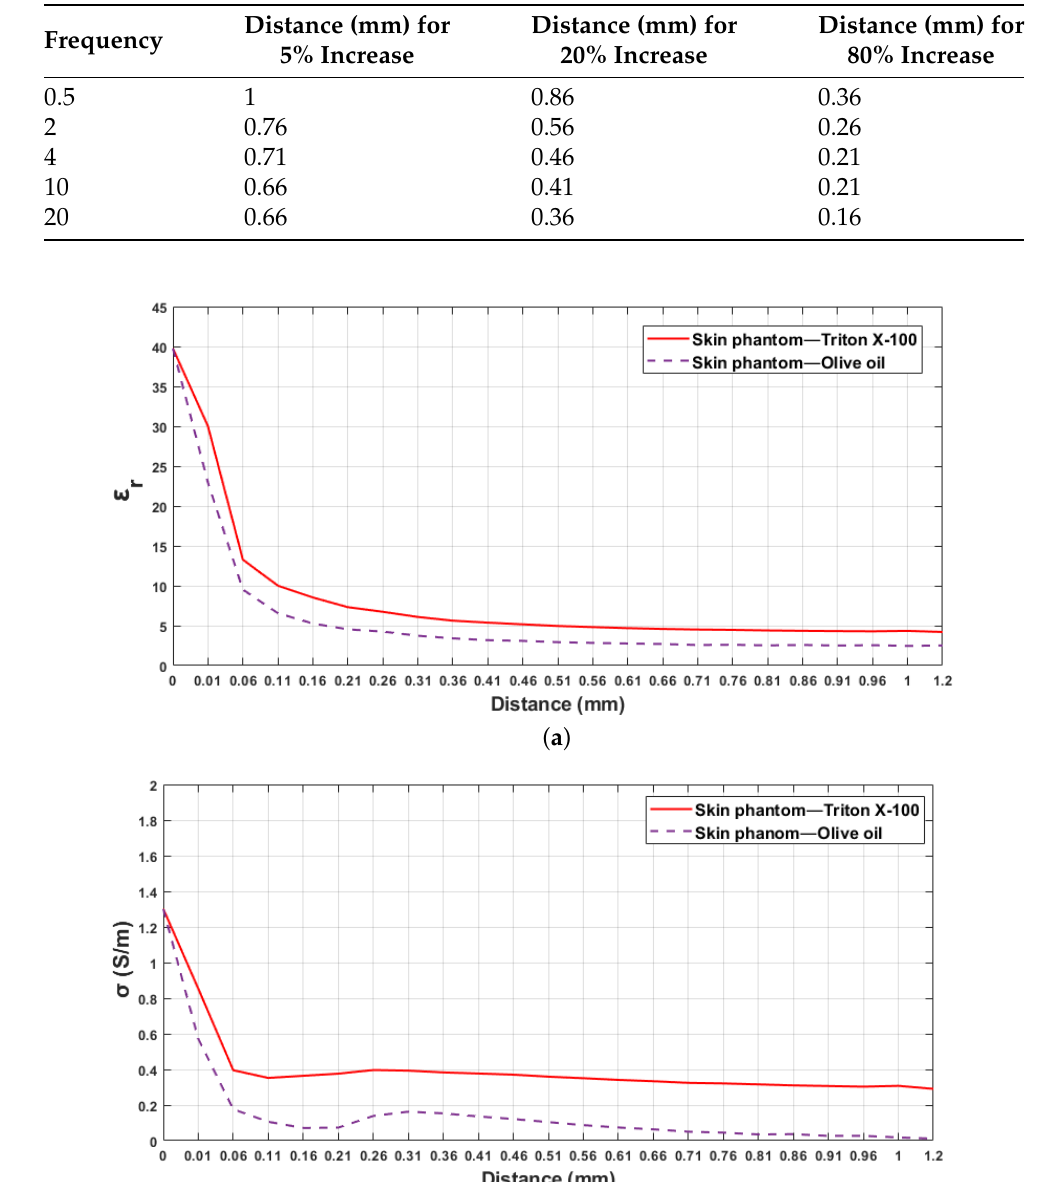
Table 6. Distances at the specified thresholds for simulated skin–olive oil configuration at 0.5, 2, 4, 10 and 20 GHz frequency points.